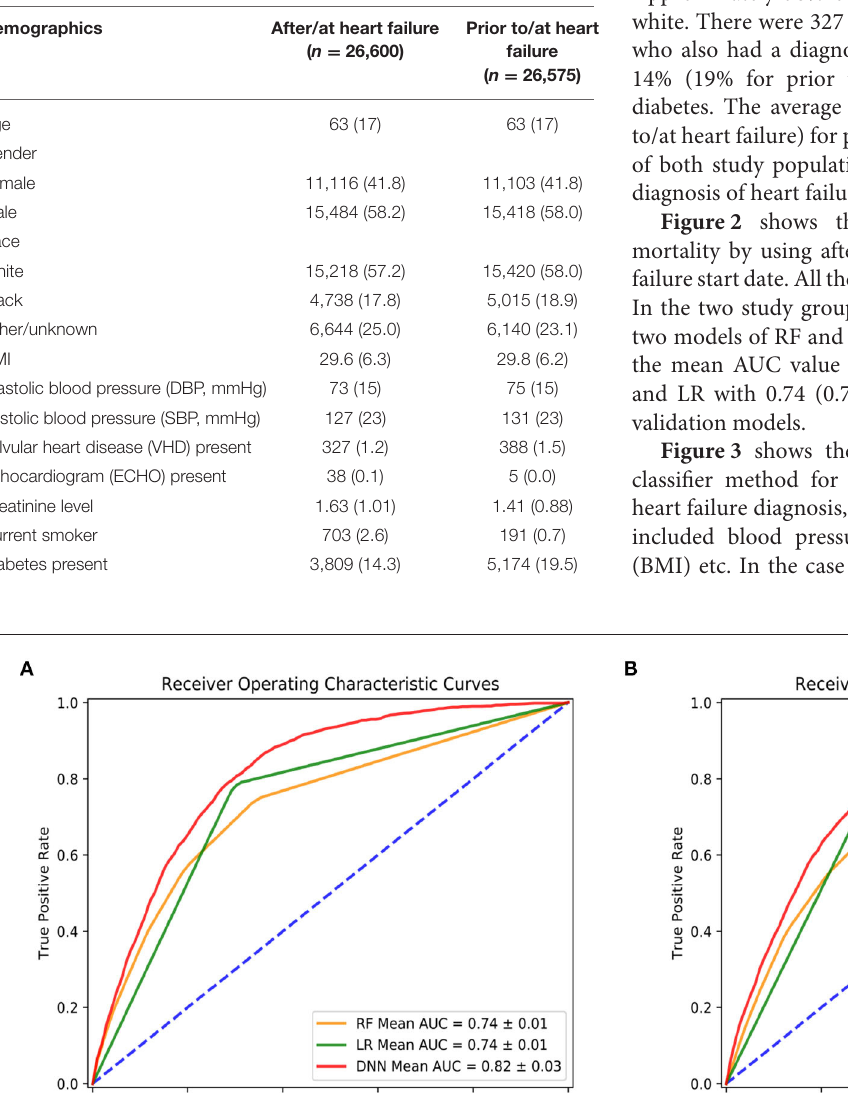
TABLE 2 | Characteristics [mean (SD) or n (%)] of the two study populations.